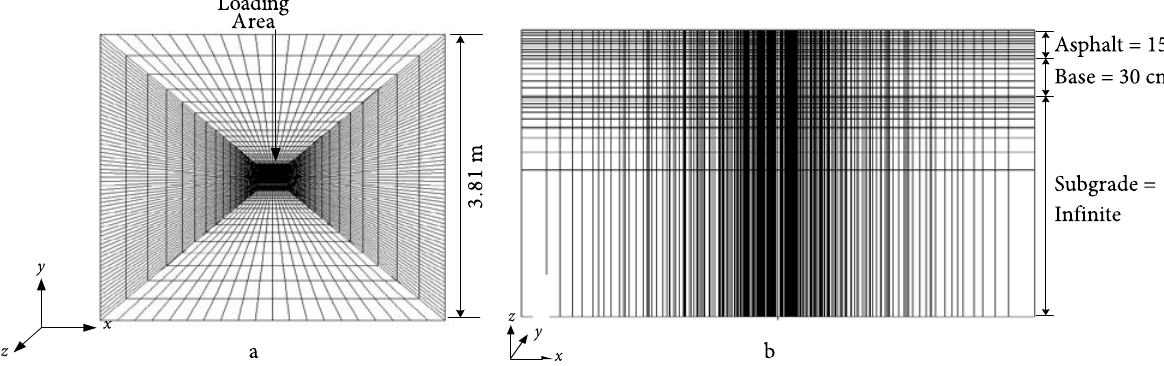
fig. 3. 3D FEM: a – top view ( y is in direction of wheel travel); b – vertical view in case of asphalt layer is 15 cm and base layer is 30 cm (Park et al.